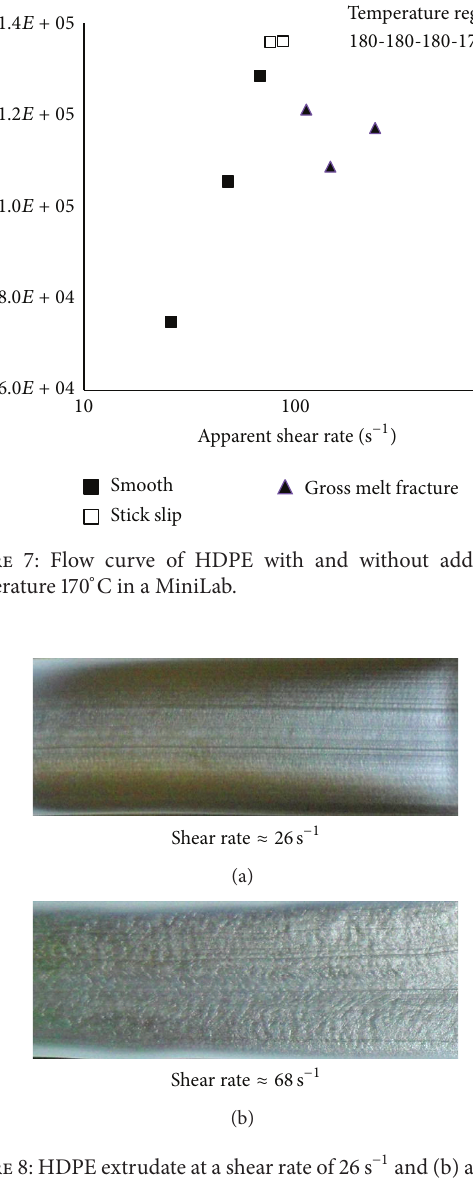
Figure 8: HDPE extrudate at a shear rate of 26 s −1 and (b) at a shear rate of 68 s −1